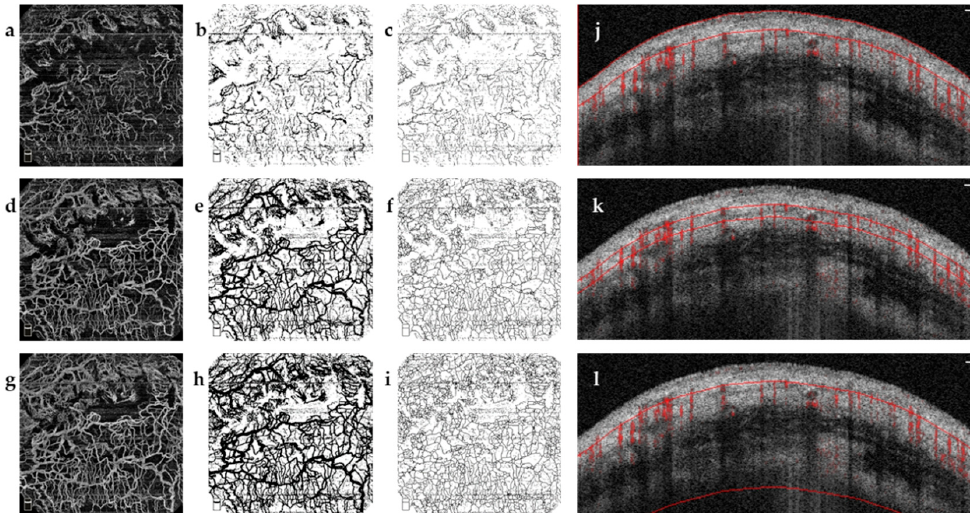
Figure 2. Image processing of anterior segment optical coherence tomography angiography (AS- OCTA). A functional filtering bleb image of right eye of a 63-year-old male patient at ten-year follow-up time point. Image processing was performed by ImageJ. ( a , d , g ) Vessel images of superficial layer (SL), Tenon’s layer (TL), and deep layer (DL) generated from the AS-OCTA. ( b , e , h ) Binarized images of SL, TL, and DL. Binarizing the angiography images into black and white pixels images for vessel density analysis. ( c , f , i ) Skeletonized images of SL, TL, and DL. Skeletonizing the binarized images to transform vessels into a single-pixel line for vessel diameter index analysis. ( a – c , j ) B-scan images of SL; red lines were determined as the depth of 0 and 150 microns from the conjunctival epithelium. ( d – f , k ) B-scan images of TL; red lines were determined as the depth of 150 and 250 microns from the conjunctival epithelium. ( g – i , l ) B-scan images of DL; red lines were determined as the depth of 150 and 1000 microns from the conjunctival epithelium.